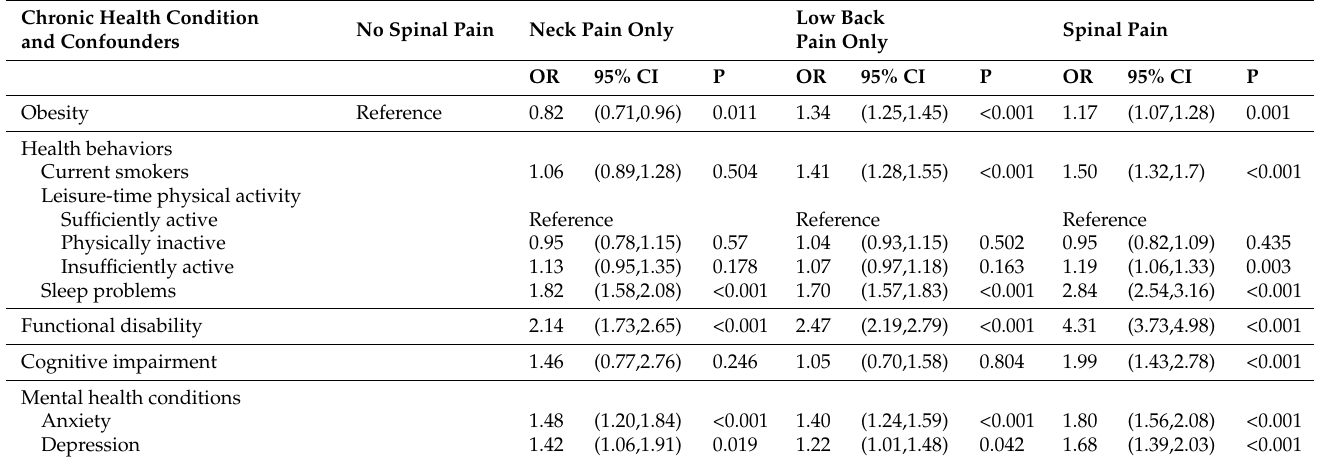
Table 5 shows Model 3 for the associations between obesity and spinal pain variables. Obesity had increased the prevalence odds of low back pain only by 34% and spinal pain by 17% compared to cases without low back pain only and without spinal pain and after adjusting for all confounders. For spinal pain, the health behaviors of tobacco use (50%), being insufficiently active (19%) and sleep problems (184%) significantly increased the prevalence odds of spinal pain compared to cases without spinal pain. For spinal pain, functional disability (331%), cognitive impairment (99%), anxiety (80%) and depression (68%) significantly increased the prevalence odds of spinal pain compared with cases without spinal pain. Table 5. The associations between obesity and spinal pain variables in the US adult population, 2016–2018